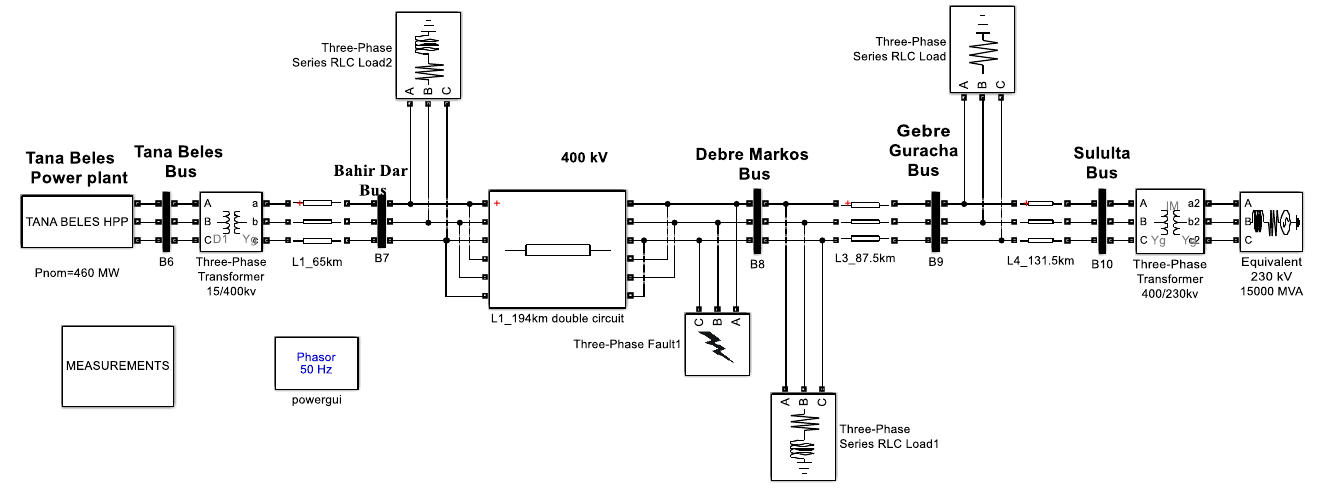
Figure 7. Overall power system network.